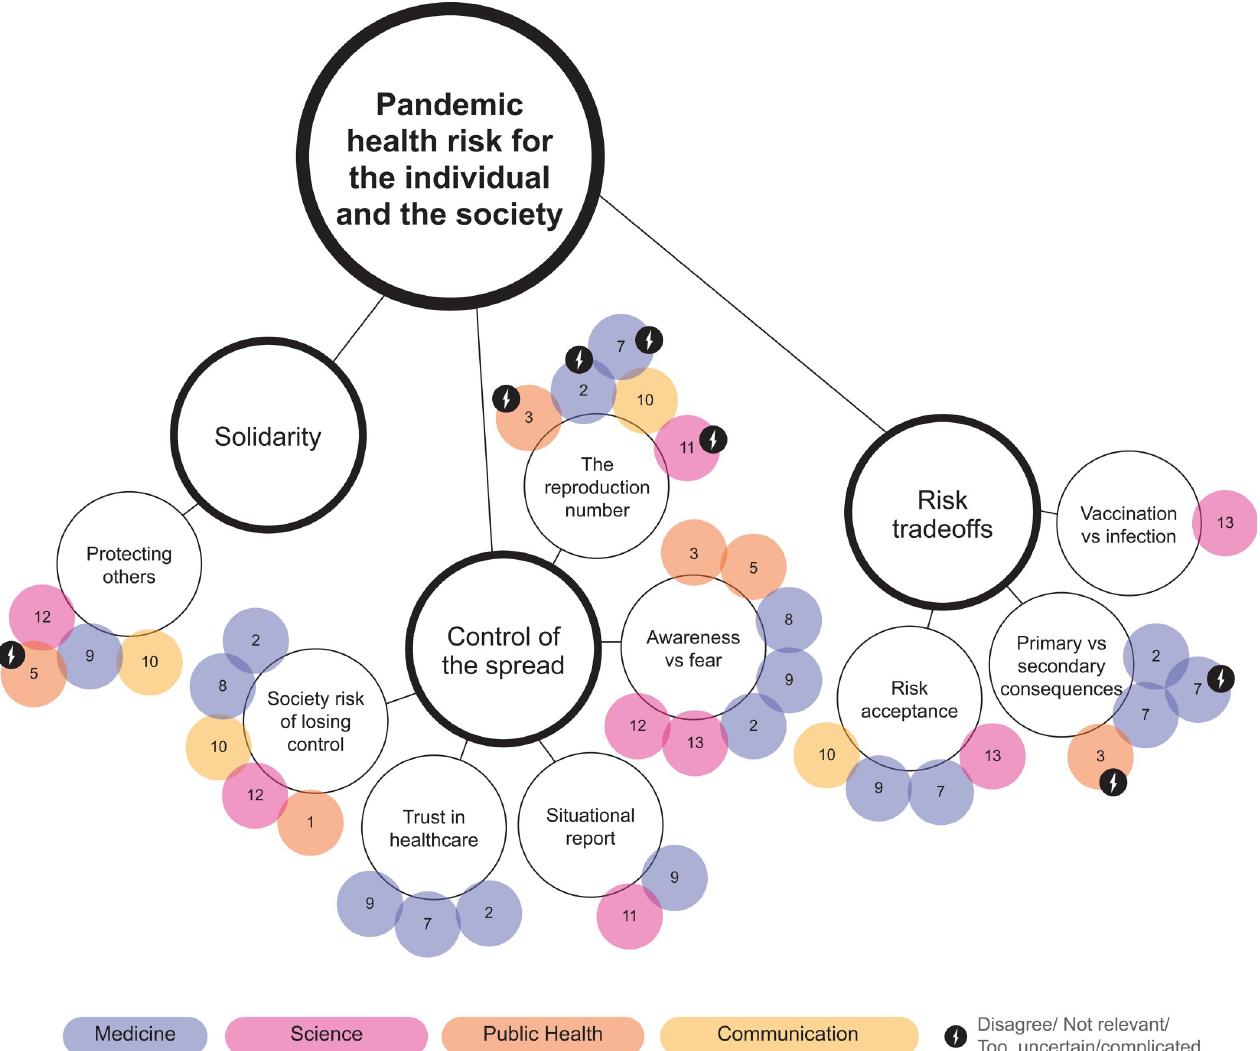
Fig 3. Bubble chart representation of information from interviews relating to the theme ‘Pandemic health risk for the individual and the society’.